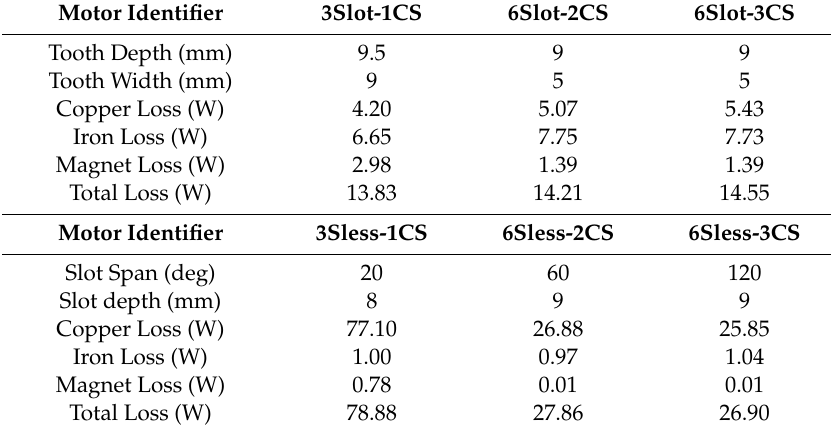
Table 5. Di ff erent loss components of six di ff erent motors without a